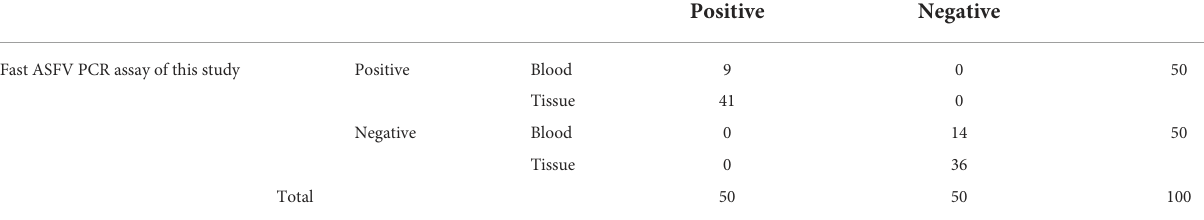
TABLE 7 Clinical sensitivity and specificity.